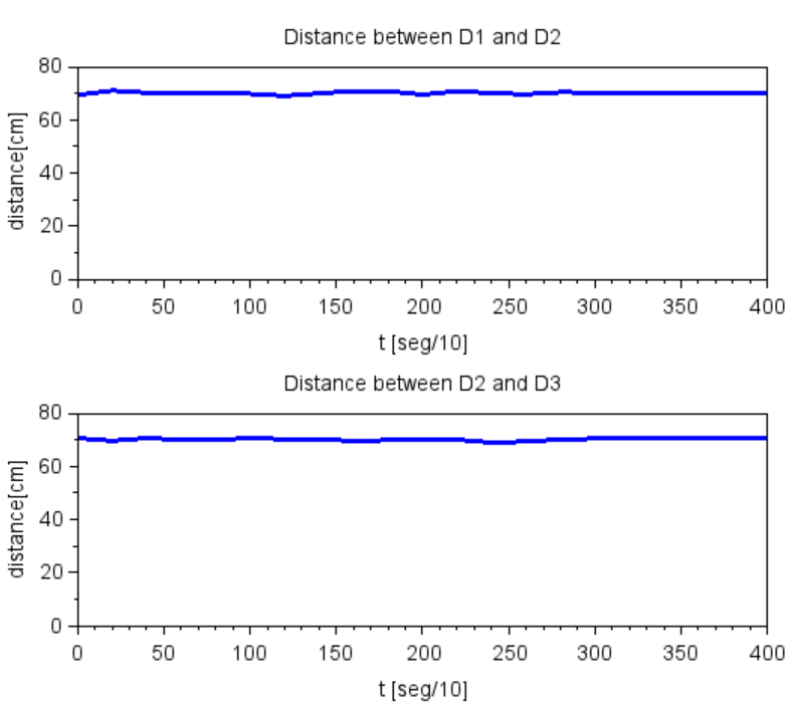
Figure 18. Euclidean distance along time between drones in Experiment